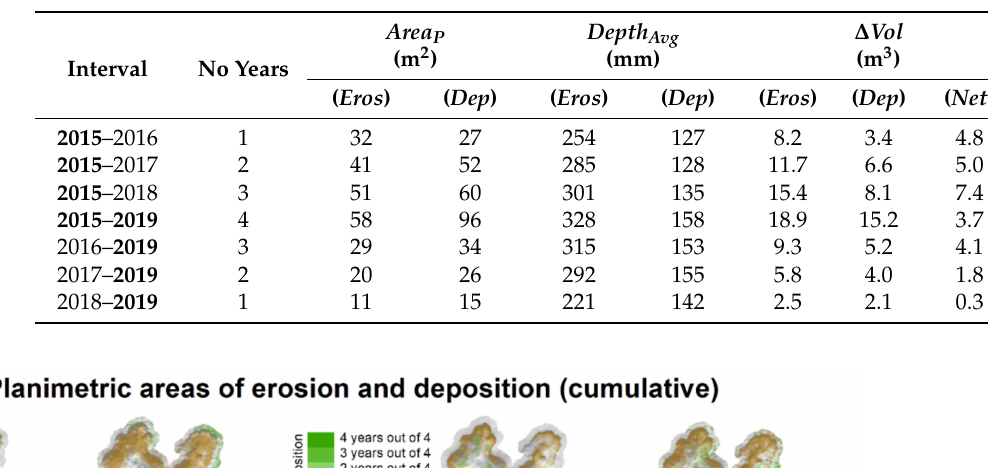
Table 4. Planimetric area ( Area P ) and average depth ( Depth Avg ) and the resultant volumetric change ( ∆ Vol ) in areas of erosion ( Eros ) and deposition ( Dep ) as measured using TLS 10 cm DEMs of Difference with a threshold for detection of change of 0.1 m. These correspond to areas of erosion and deposition in Figure 8. Bolded year is reference year for each interval.